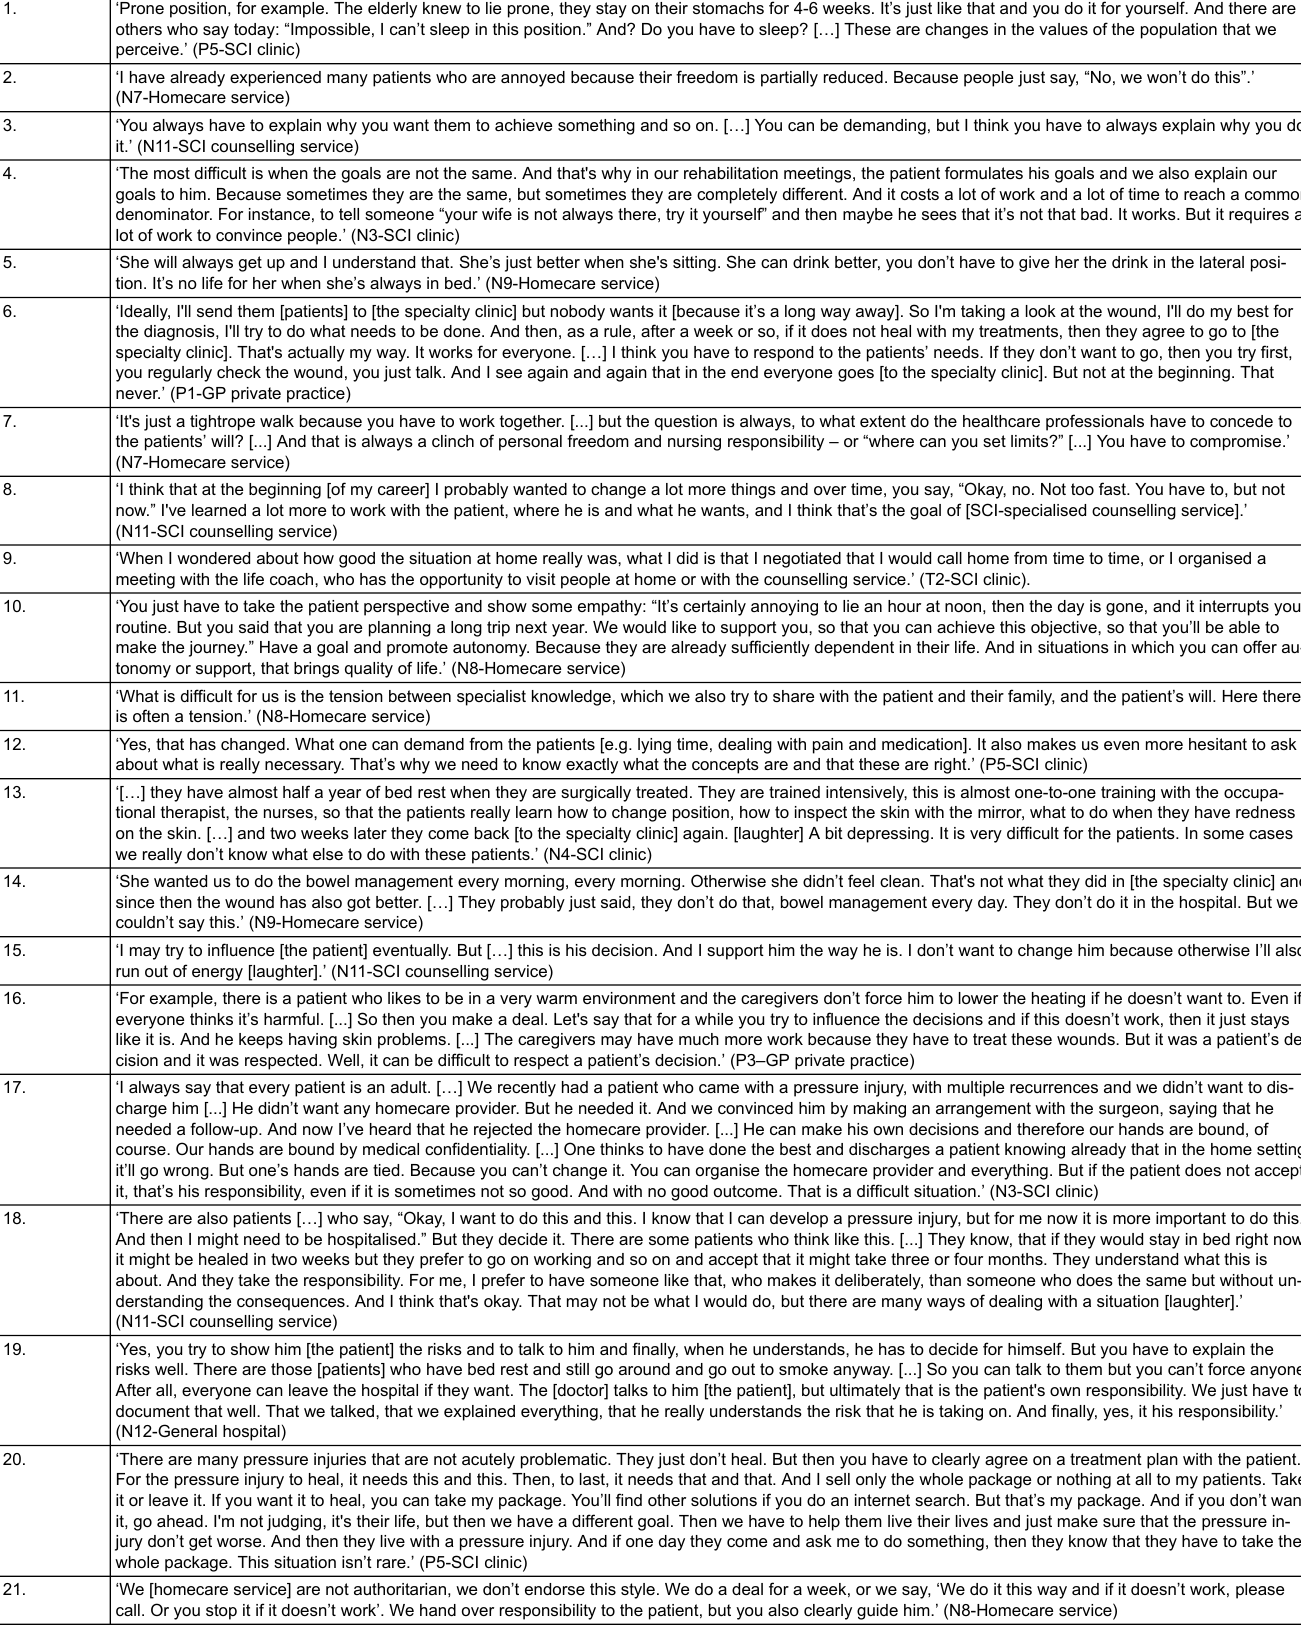
for themselves (table 3, quotes 15 and 16). Another possi- ble reason is psychosocial barriers, linked, for instance, to a lack of acceptance of the SCI (table 3, quotes 17 and 18). Table 4: Challenge 2 – negotiating priorities and setting common